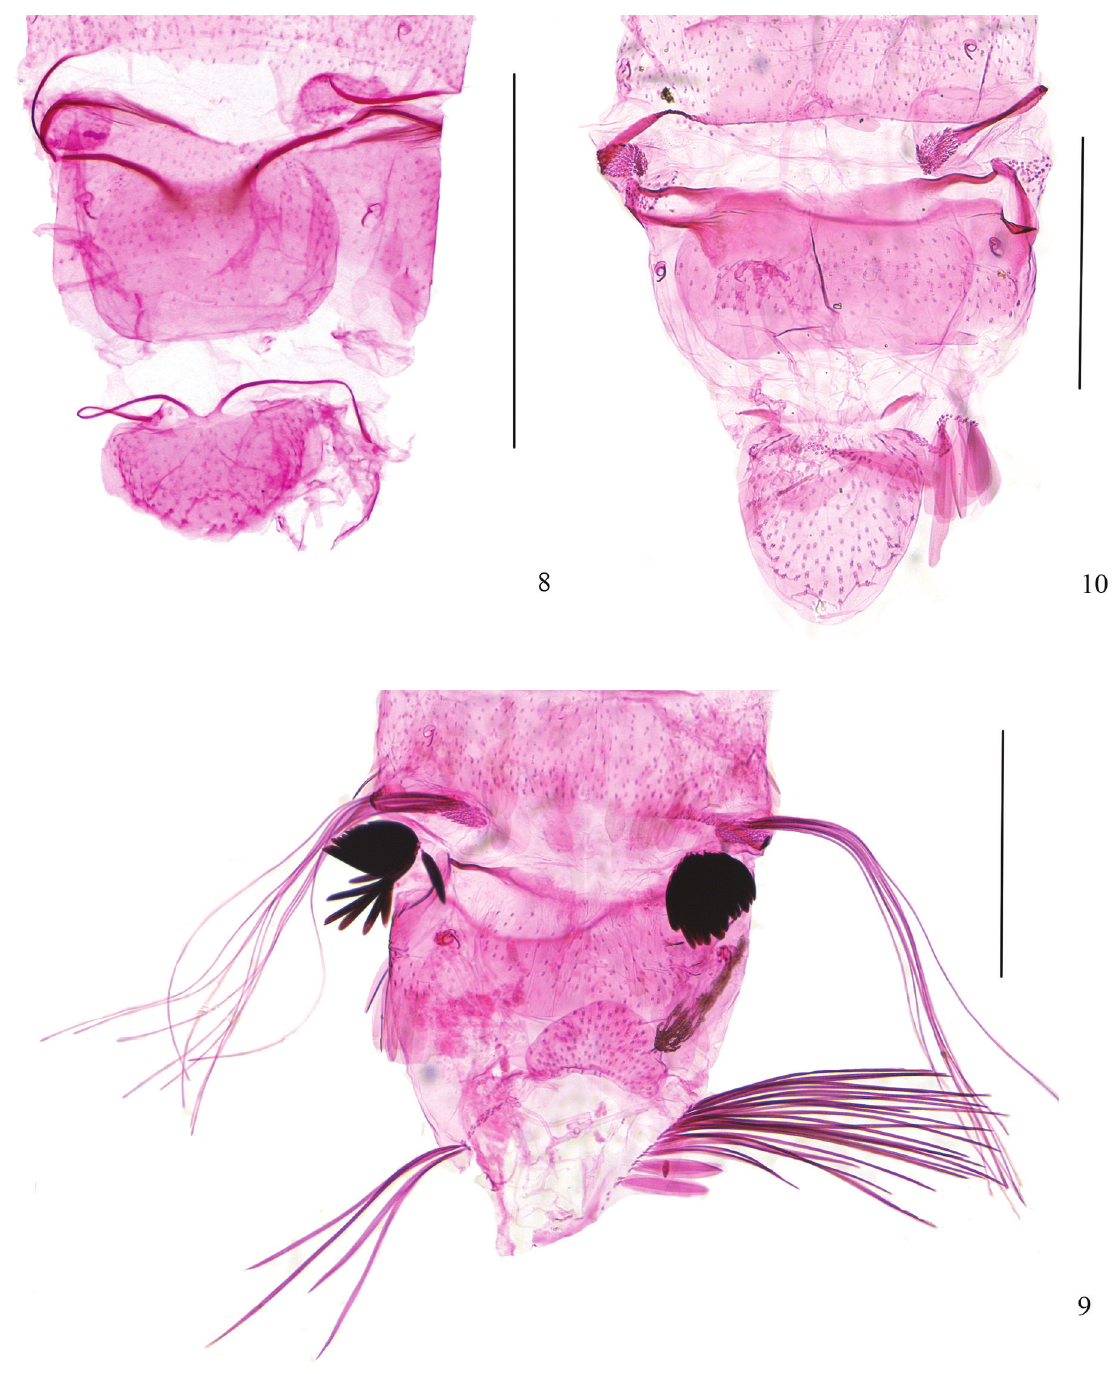
Figures 8–10. Male pregenital structures of Liocrobyla spp. 8. L. desmodiella , slide no. LTT12611 (NKU); 9. L. lobata , slide no. LIU0028; 10. L. indigofera sp. n., holotype, slide no. LIU0030. Scale bars: 0.5 mm. with scape white on front and black dorsally, other seg- ments brownish grey with darker rings. Thorax yellowish fuscous, tegula brownish grey. Forewing ground colour brownish grey, darker towards costa, a white stripe from costal 1/3 to before 1/2, then curved downwards to near tornus; two white stripes beyond distal 1/3 and 2/5 on costa obliquely to middle of wing; two longitudinal striae near apex, with the costal one indistinct, one white spot